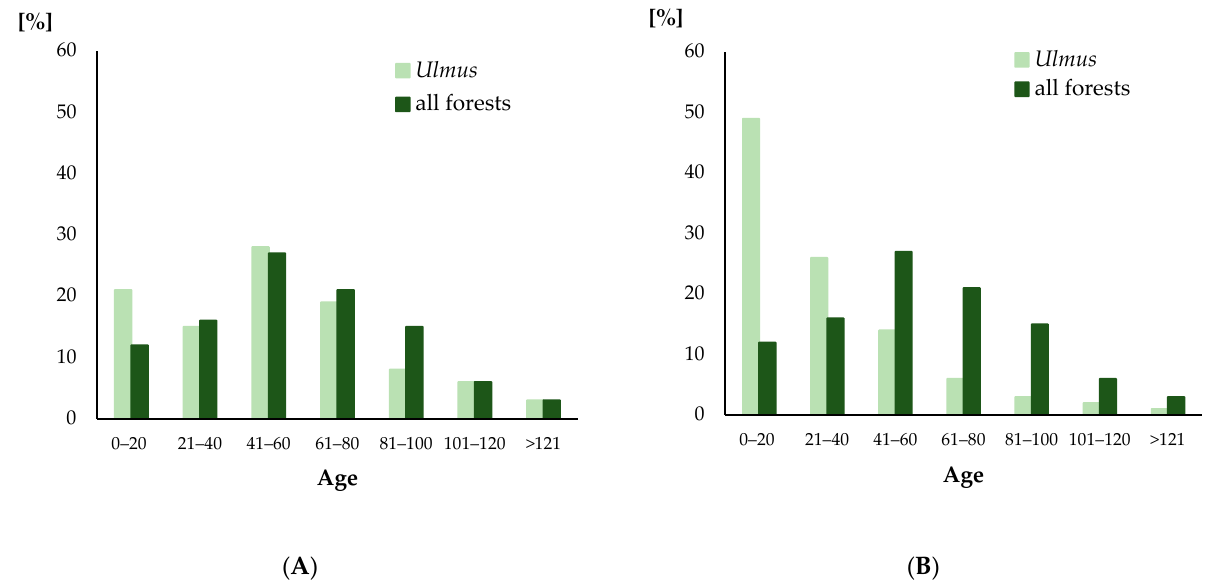
Figure 2. The age distributions of all elms ( A ) and elms in stands where they have a dominant position ( B ) compared with all forests in Poland.